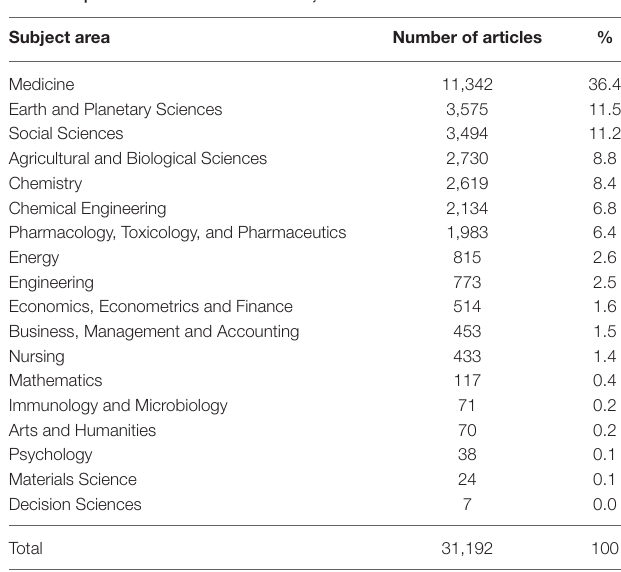
TABLE 4 | Article distribution across publishers. TABLE 5 | Article distribution across subject